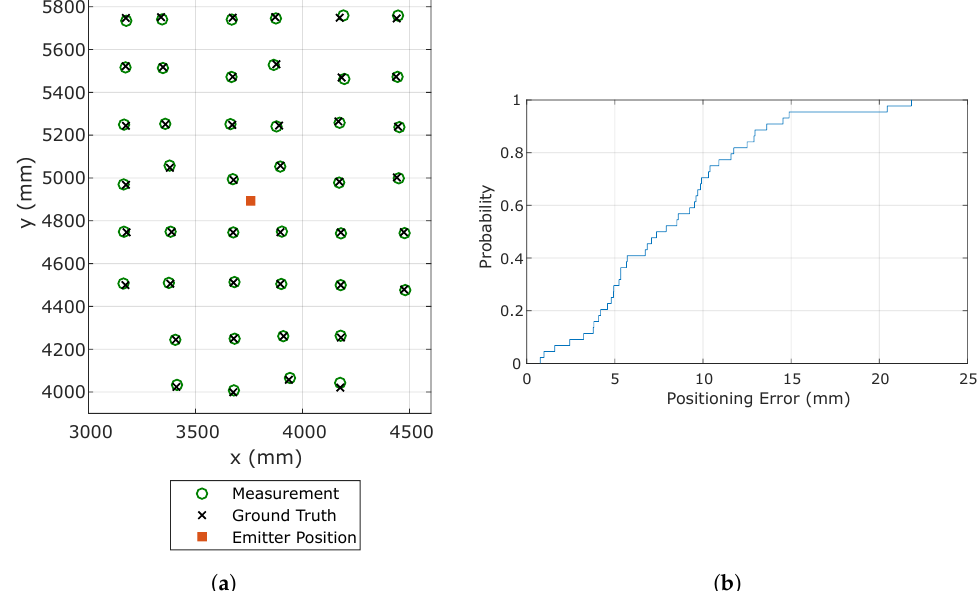
Figure 8. Positioning results using Emitter 2. ( a ) Estimated and true receiver positions; ( b ) CDF of the positioning